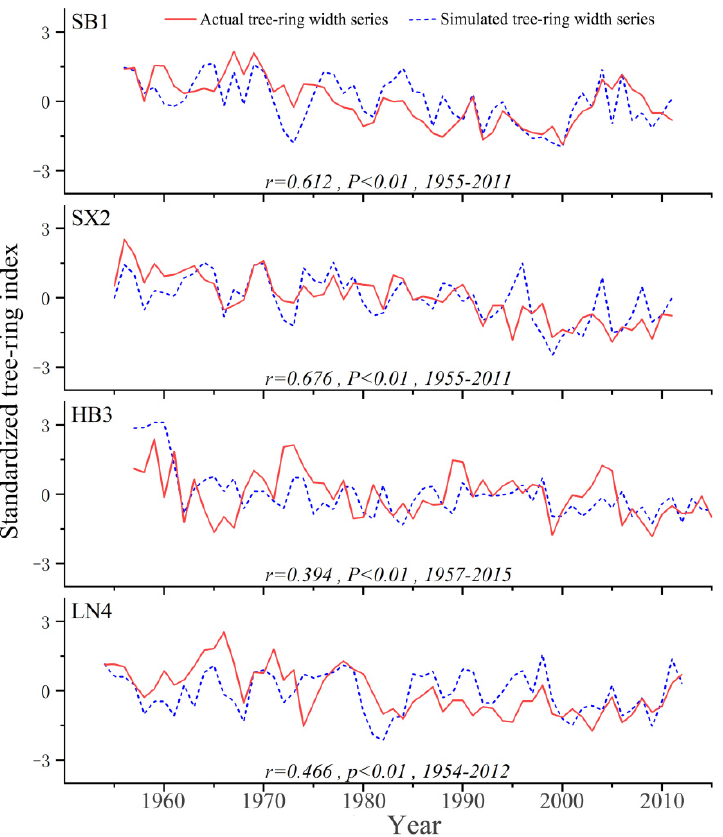
Figure 3. Comparison between the actual (red straight line) and simulated (blue dashed line) tree-ring width series (Standardized tree-ring index) during the past several